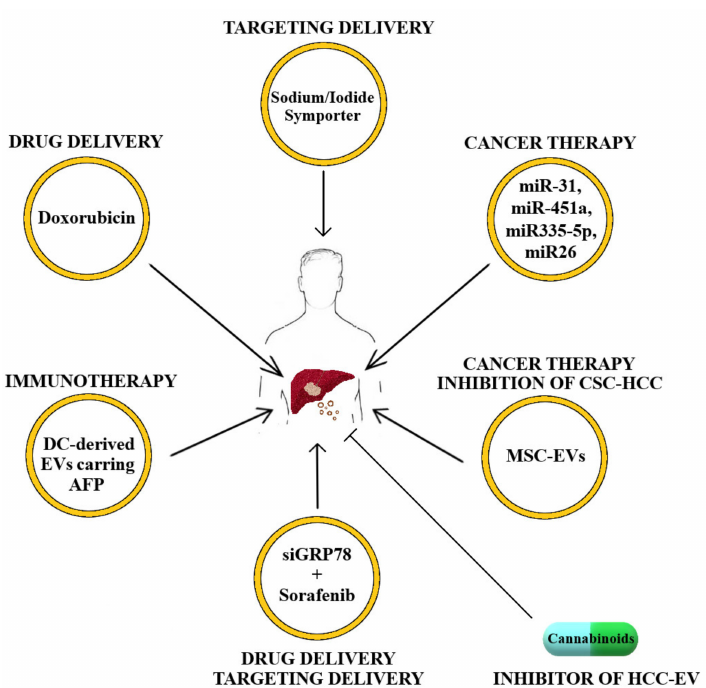
Figure 1. Schematic representation of extracellular vesicle (EV) therapeutic strategies for hepatocellular carcinoma (HCC) treatment. Note: CSC = cancer stem cell; MSC EVs = mesenchymal stem cell (secreted EVs); DC = dendritic cell; AFP =